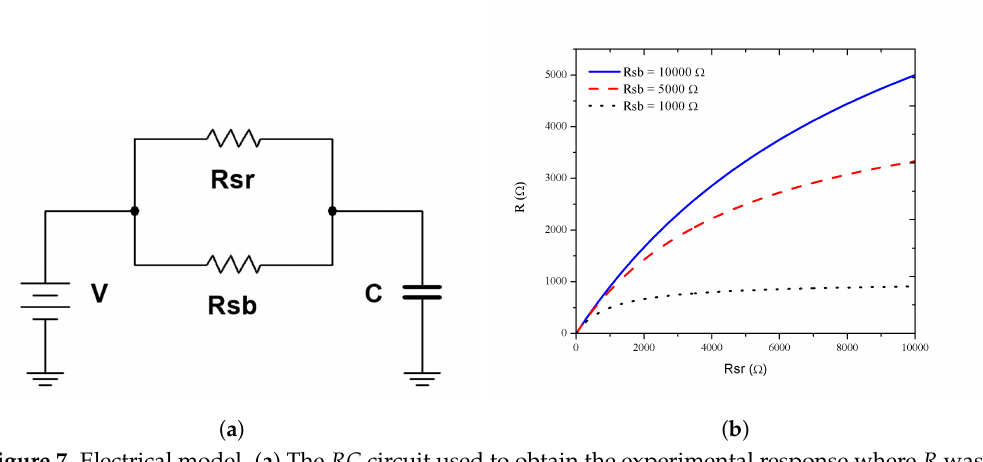
Figure 7. Electrical model. ( a ) The RC circuit used to obtain the experimental response where R was the parallel of R sr with R sb . ( b ) R versus R sr with fixed R sb of 1, 5, and 10 k Ω